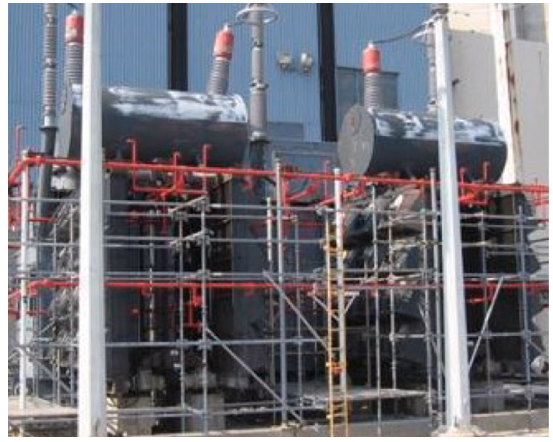
Figure 4. Site operating GE 980MVA Step-Up transformer.